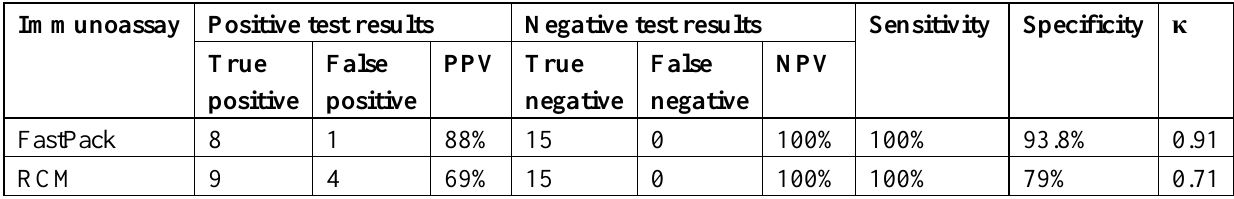
Table 2. Diagnostic accuracy of FastPack and magneto-immunoassay (RCM) in comparison with the Immulite assay analysed by methods described by Cohen [23] and Altman and Bland